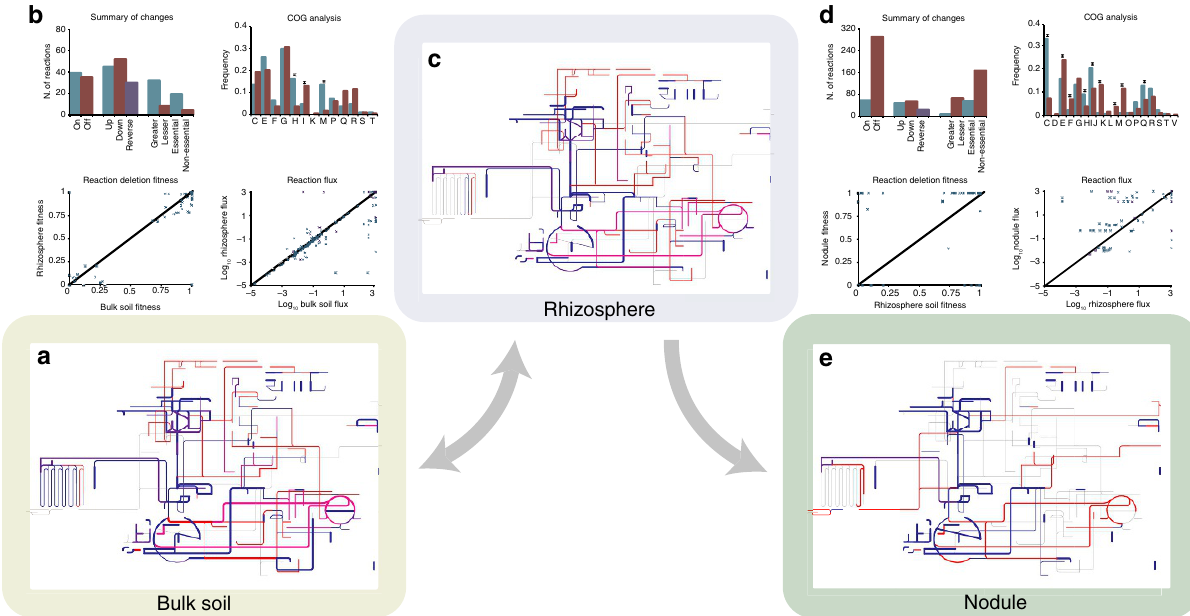
Figure 2 | The effect of niche conditions on the reconstructed metabolic network. Networks were visualized following optimization in ( a ) bulk soil, ( c ) rhizosphere and ( e ) nodule environments. Lines are colour coded based on fitness effect of deleting each reaction: blue indicates a fitness decrease o 1%; dark purple indicates a fitness decrease o 50%; bright purple indicates a fitness decrease 4 50%; and red indicates a fitness decrease 4 99%. Thin grey lines indicate inactive reactions. Line thickness shows the flux through each reaction on a log scale. The graphs summarize the metabolic changes detected during the ( b ) bulk soil to rhizosphere and ( d ) rhizosphere to nodule transitions. Summary of changes graphs: on and off—reactions carrying flux only in the second and first environment, respectively; up and down—reactions carrying increased flux ( Z 50%) in the second and first environment, respectively; reverse—reactions whose directionality is switched; greater and lesser—reactions whose removal have a greater ( Z 10%) fitness impact in the second and first environment, respectively; essential and non-essential—reactions essential only in the second and first environment, respectively. The nine classifications are not mutually exclusive. The reactions present in each category are described in Supplementary Data 3 and 4. The COG analysis graphs summarize the functional annotation of the genes associated with the reactions in the summary of changes graphs. The blue and red bars include the genes associated with the blue and red bars, respectively, in the summary of changes graphs. Asterisks indicate statistically significant changes ( P value o 0.01) as determined by Pearson’s w 2 -tests. In the reaction flux figures, each point represents the amount of flux through individual reactions in the two environments. Blue and purple symbols indicate reactions with the same or reverse directionality, respectively. The angled line indicates the position of a perfect correlation. In the reaction deletion fitness figures, each point represents the fitness of individual reaction deletion mutants in the two environments. The angled line indicates the position of a perfect